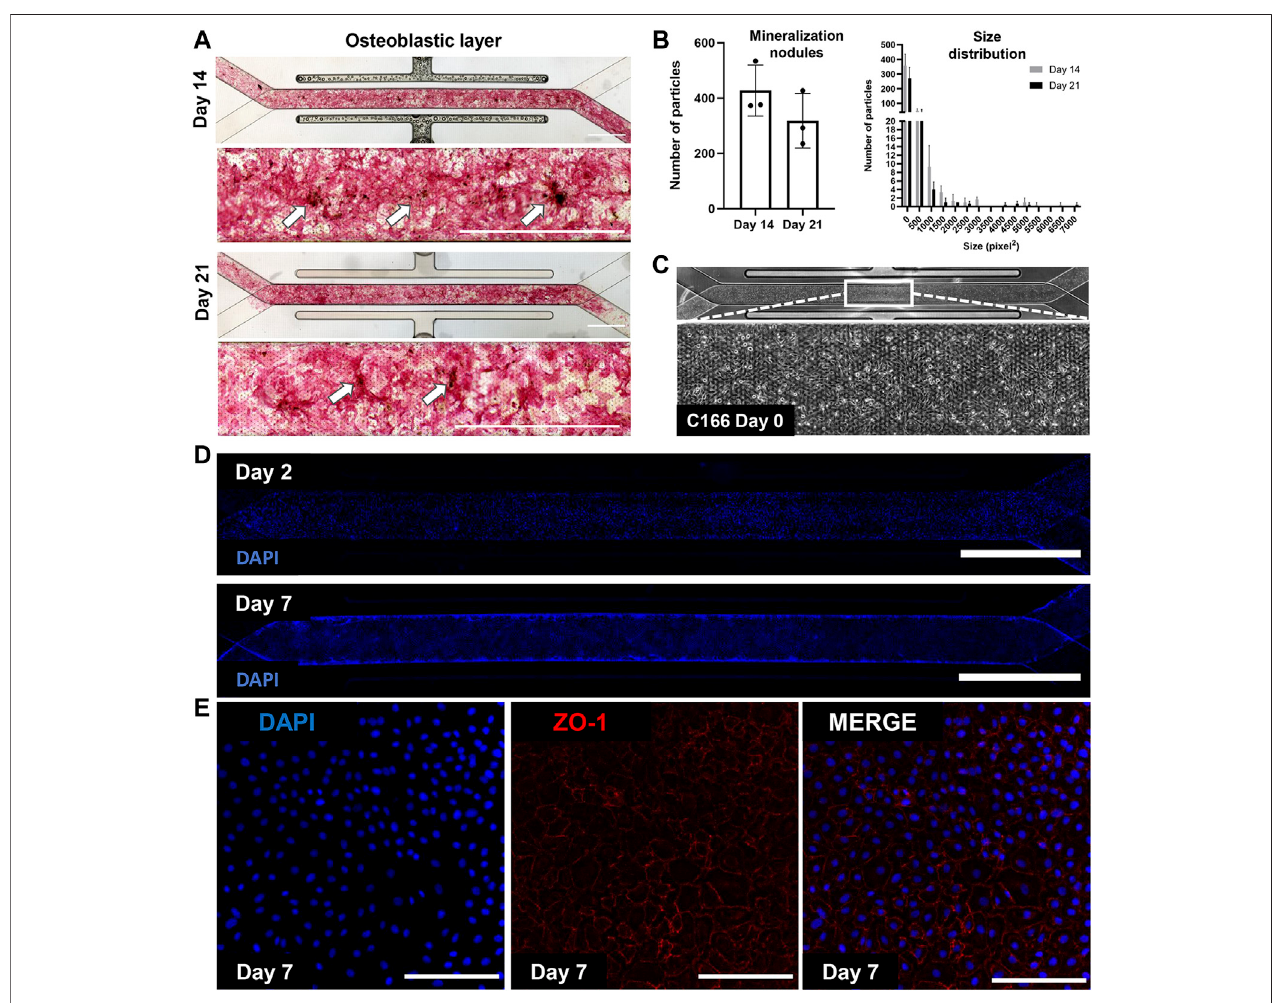
FIGURE 2 | Mineralized osteoblastic layer and C166 endothelium formation with tight junction expression. (A) Representative images of positive mineralization by alkaline phosphatase and Von Koss staining on D14 and D21. Arrows indicate calcium nodules and scale bar = 2 mm. (B) Quanti fi cation of mineralization using particle analysis via ImageJ of D14 and D21 mineralized chips. (C) Representative image of C166 monolayer on the chip on D0 post-seeding. (D) Representative fl uorescent images of C166 cells (nuclei, DAPI) on Day 2 and Day 7. Scale bar = 2 mm. (E) C166 endothelium formed cobblestone morphology and expressed tight junction protein, ZO-1 (red). Scale bar = 100 μ